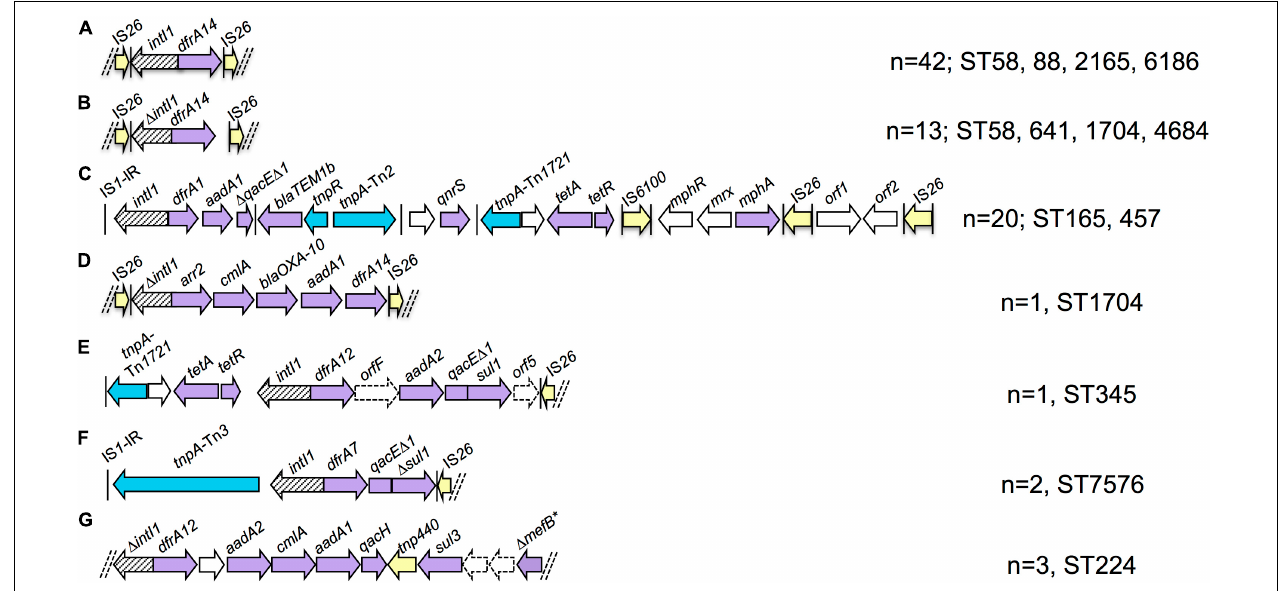
FIGURE 3 | Schematic representation of integron structures identified in draft assemblies (not to scale). Purple arrows - resistance genes; yellow arrows - insertion sequences; blue arrows – transposon-associated genes. Vertical bars indicate inverted repeats. Parallel dashed bars indicate scaffold breaks. Letters (A–G) refer to the different integron types identified and referred to in